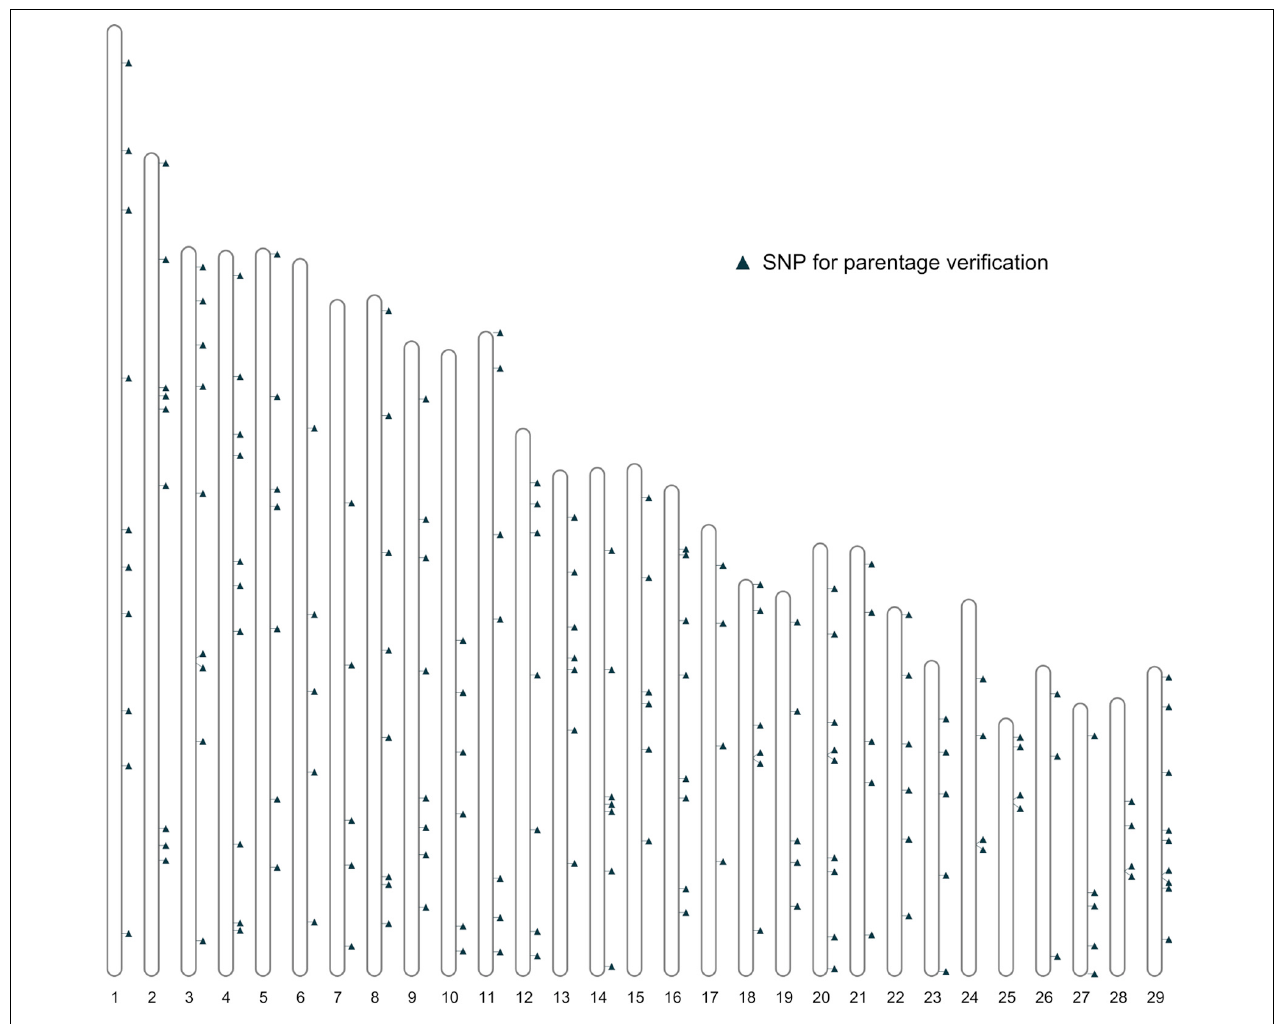
FIGURE 4 | The distribution of the SNPs for parentage verification on